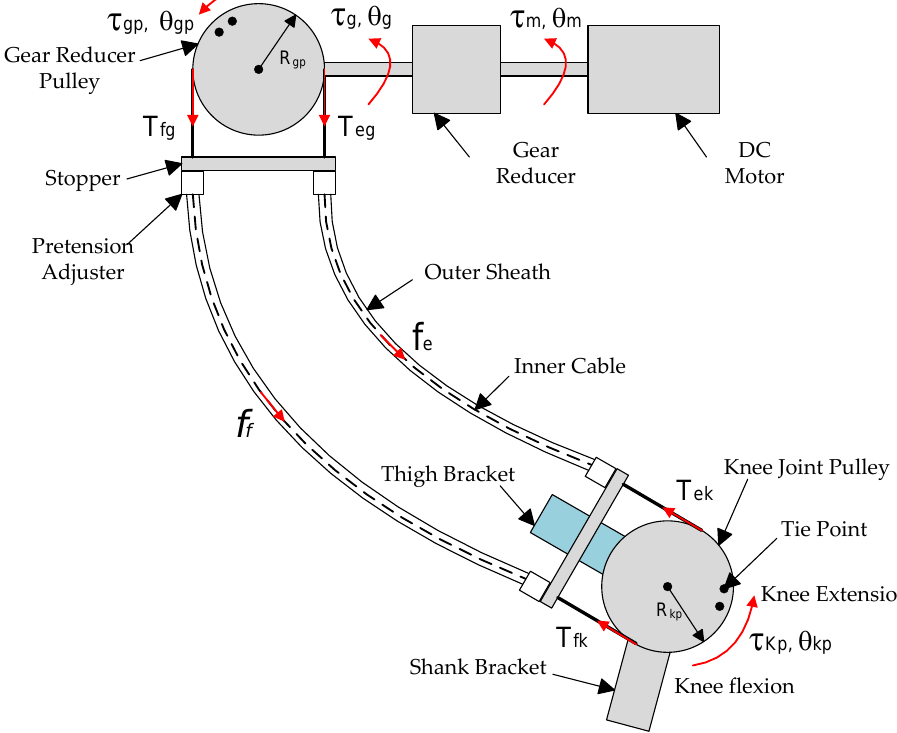
Figure 3. The Bowden cable transmission system for the soft knee exoskeleton. Backlash and friction exist in both the Bowden cables and gear reducer of the DC motor.